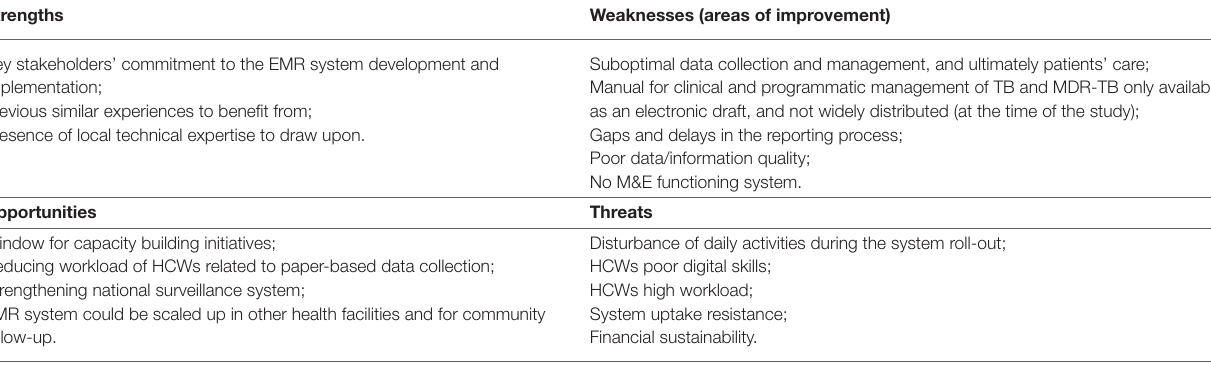
TABLE 1 | SWOT analysis. Strengths Weaknesses (areas of